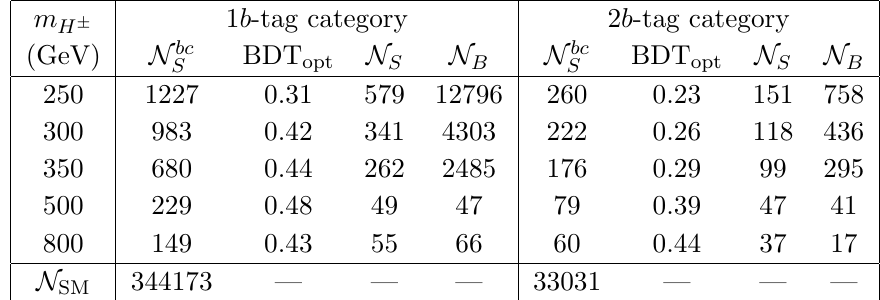
| | Table 4 . The number of the SM background events ( ) for the 1 b -tag category at the LHC N SM ( p s = 13 TeV) with = 50 fb (cid:0) 1 that enters in the MVA. The minimum number of signal events L bc that can be discovered with 5 (cid:27) signi(cid:12)cance using our MVA is denoted by (this is before the S N optimal BDT cut as shown in the third column). The signal and background events that survived after the optimal BDT cut are denoted by and , respectively, and they lead to 5 (cid:27) N S N B